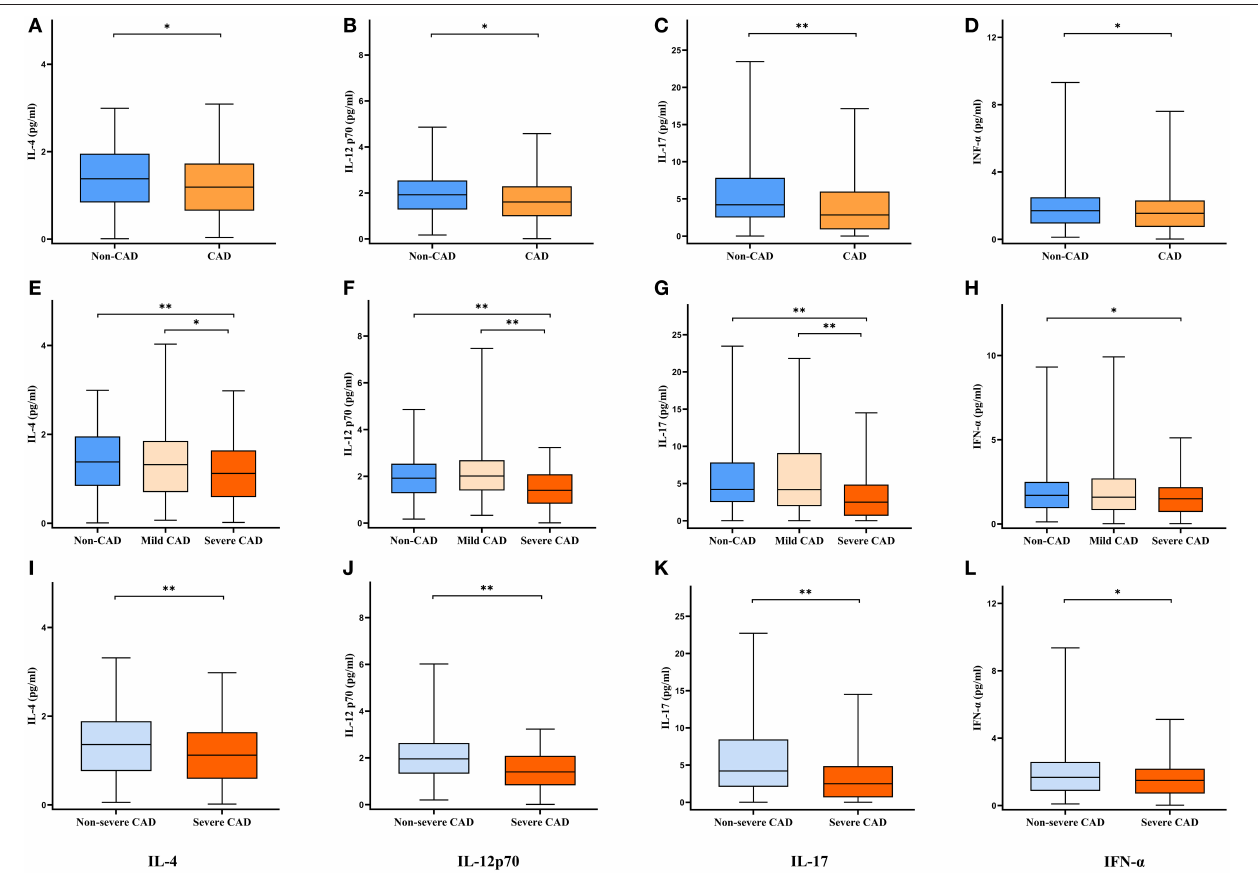
FIGURE 1 | Serum cytokine levels under different groupings. Data are expressed as median with 25th and 75th percentiles. (A–D) Non-CAD group vs. CAD group. (E–H) Non-CAD group vs. Mild CAD group vs. Severe CAD group. (I–L) Non-severe CAD group vs. Severe CAD group. * P < 0.05, ** P < 0.01.